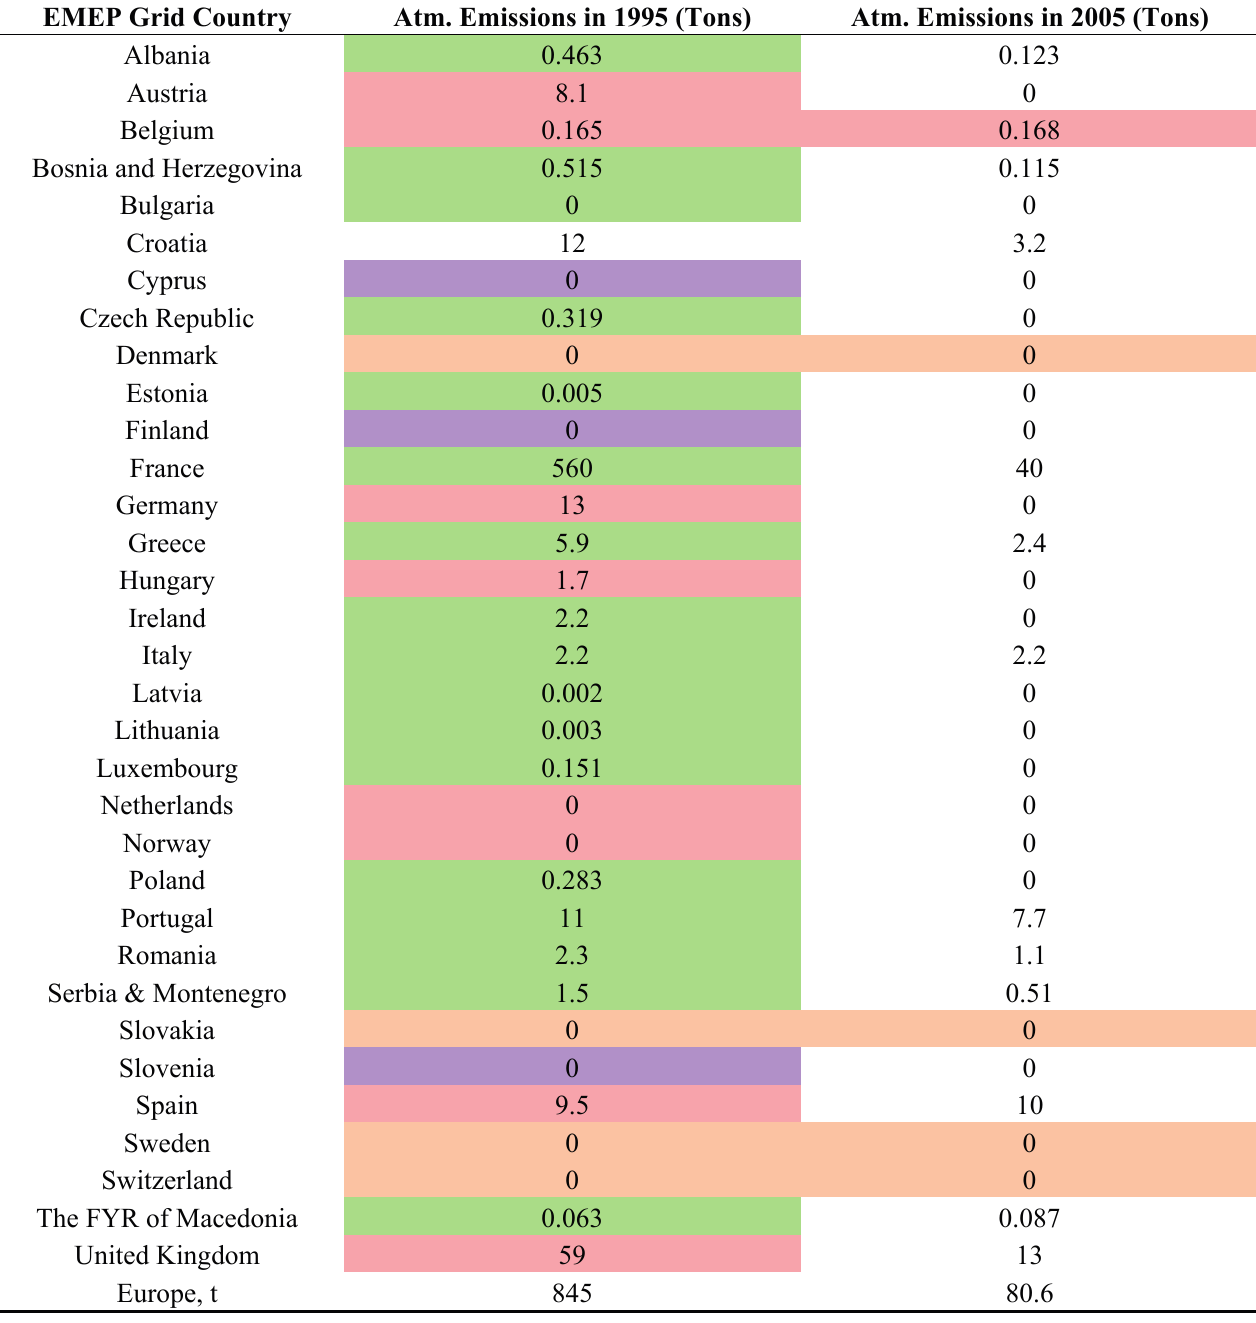
Table 1. Atmospheric emissions per country for 1995 and 2005 used for the